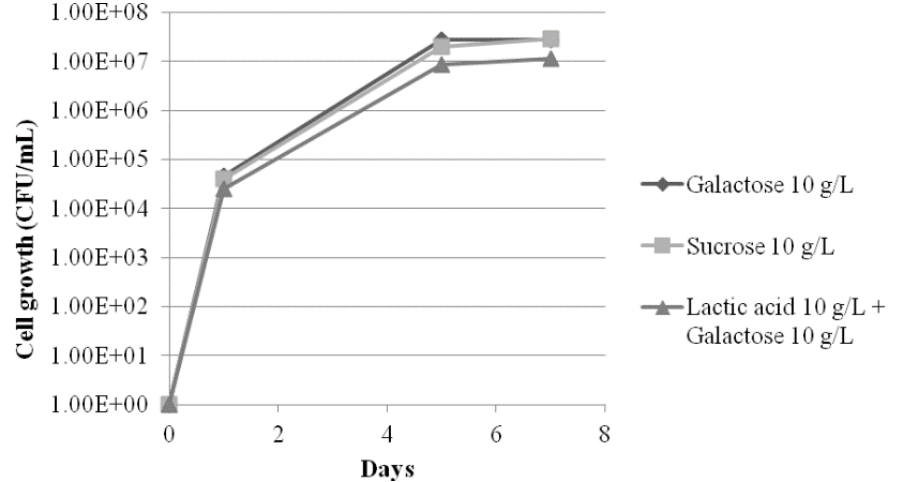
Figure 1. Growth kinetics of one isolated strain (Mi4) in three different carbon sources.